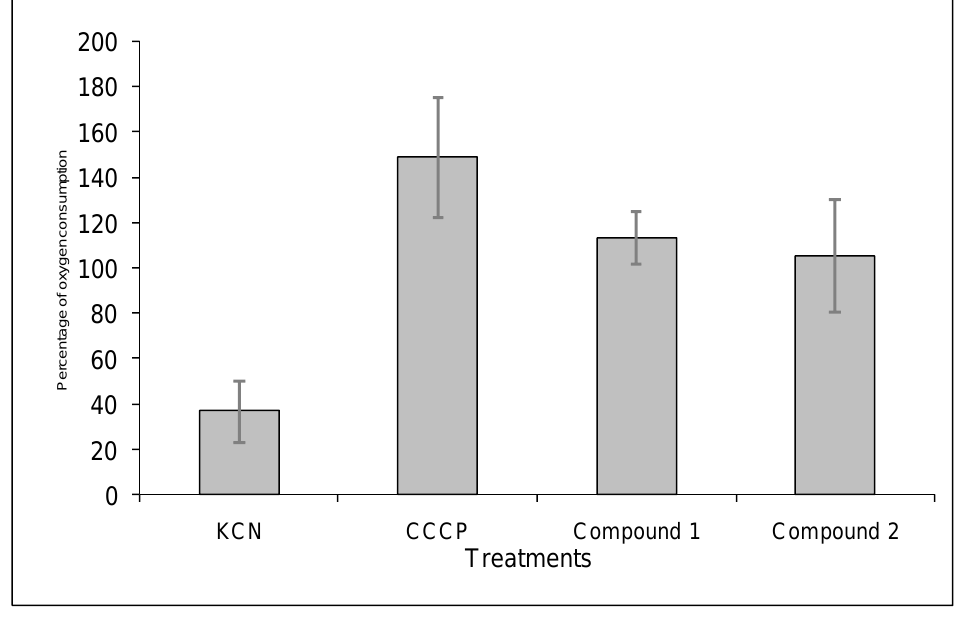
Figure 7 . Effect of salvic acid and acetylsalvic acid on oxygen consumption of B. cinerea conidia. 10 μ g mL -1 CCCP and 650 μ g mL -1 KCN were used as control. Diterpenoids were added to conidia suspension dissolved in methanol at 160 μ g mL -1 . After eight min of incubation, the percentages of inhibition in the presence of the compounds relative to the basal oxygen consumption were calculated. Each bar represents the average of at least three independent experiments ± standard